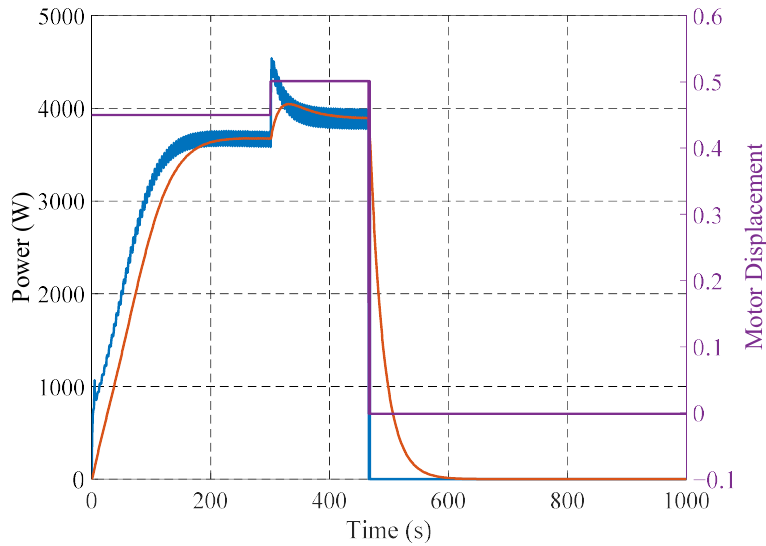
Figure 18. The generated power and the ratio of motor displacement under the traditional MPPT control.